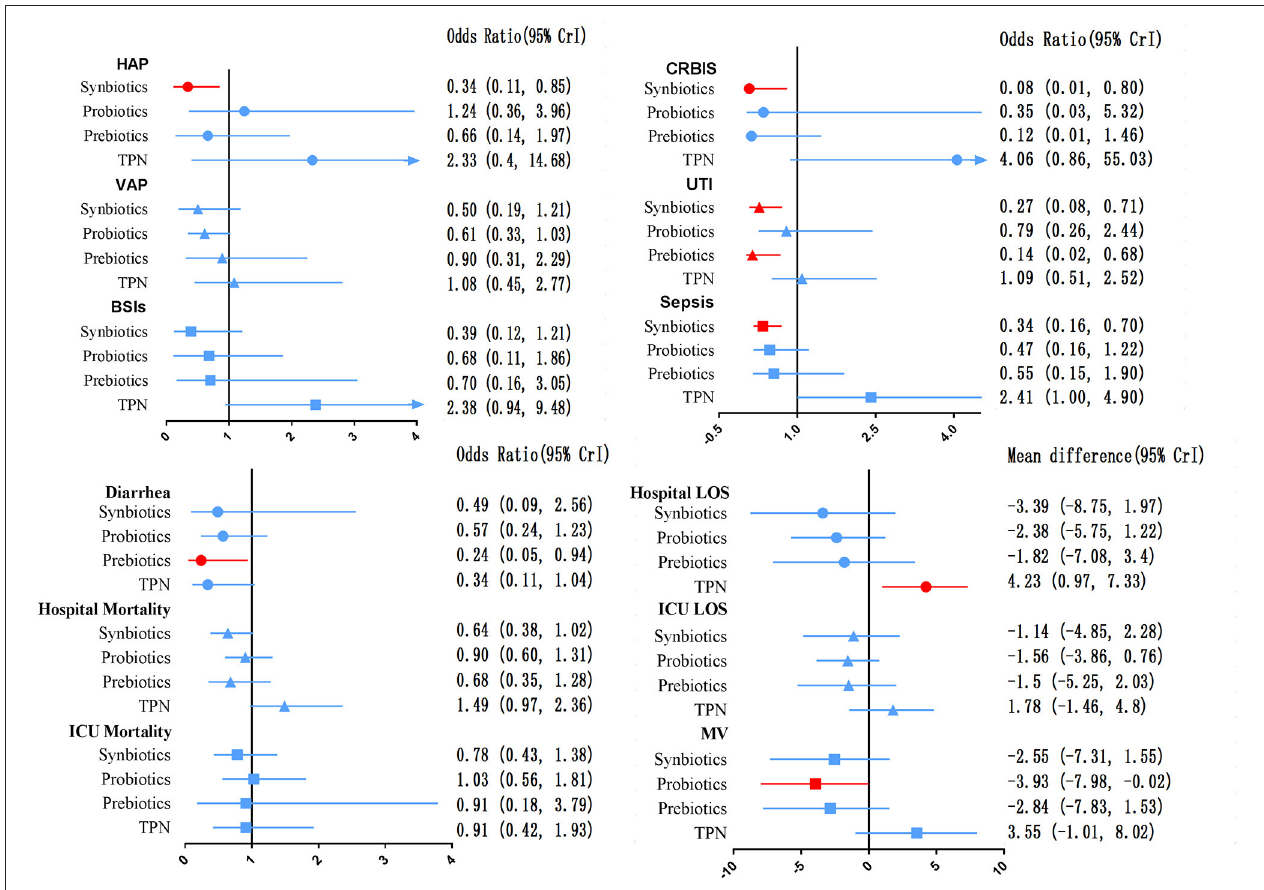
FIGURE 6 | Forest plot of the effect estimate for each active intervention vs. EPN on secondary outcomes. Estimates are presented as odds ratios (OR) and 95% CrI. OR < 1 favor the treatment. BSIs, Bloodstream infections; CrI, credible interval; CRIBS, Catheter-related bloodstream infection; EPN, Enteral nutrition or adjuvant peripheral parenteral nutrition; HAP, Hospital acquired pneumonia; TPN, Total parenteral nutrition; LOS, length of stay; MV, Duration of Mechanical ventilation; UTI, urinary tract infection; VAP, Ventilator-associated